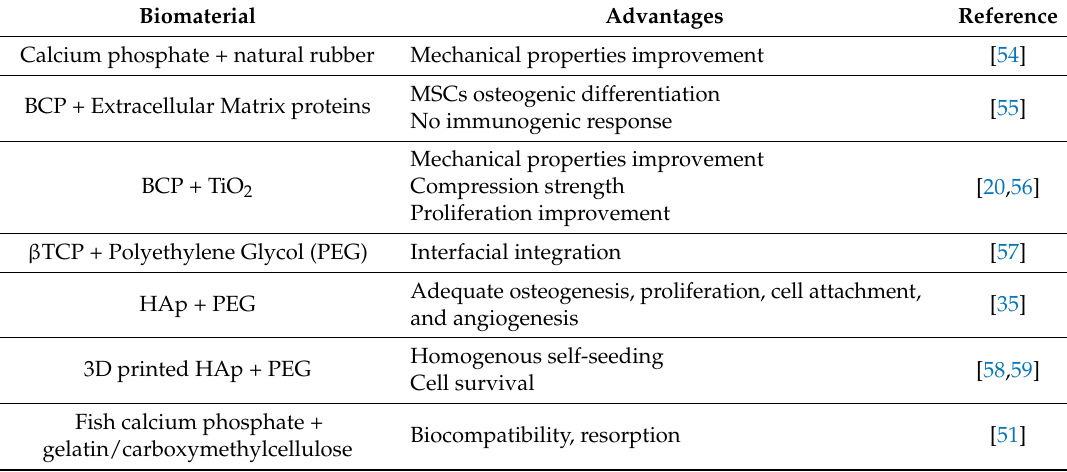
Table 2. Composites of calcium phosphate and several materials and benefits derived from these combinations as scaffolds in bone tissue